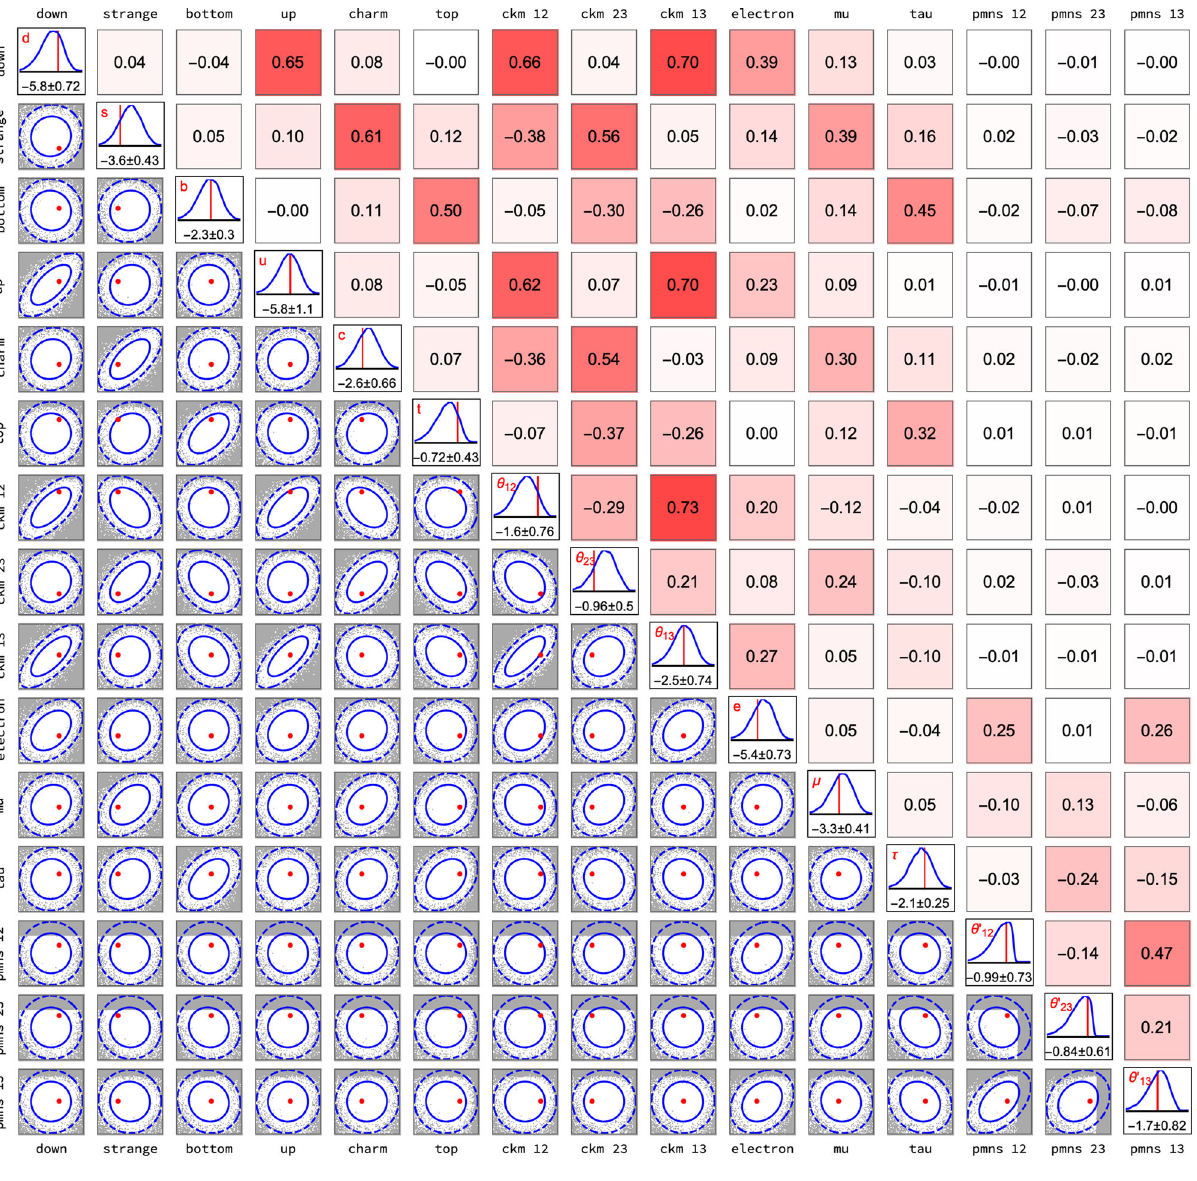
one dimensional marginal distributions over a 3 sigma range with the red lines indicating the experimental value. The numbers on the bottom of each entry are the mean and standard deviation of the theoretical distributions. In the upper triangle, we show the correlation